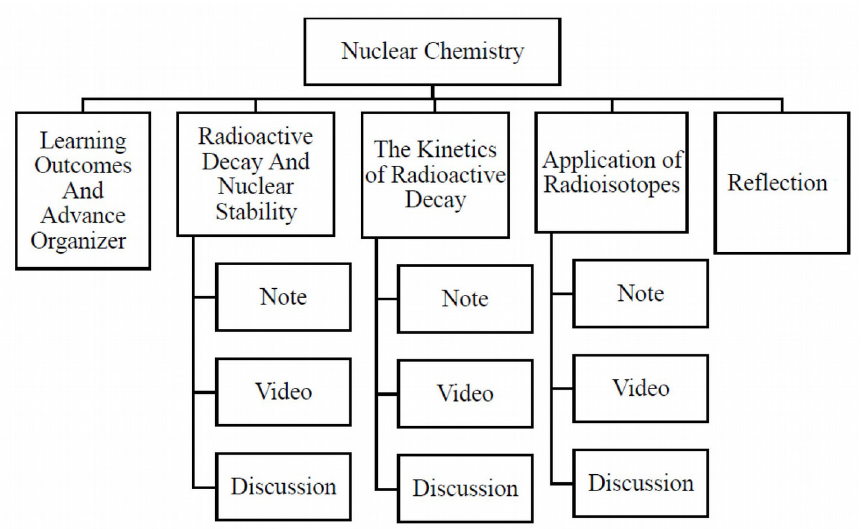
Figure 8. Storyboard used in designing the content of module (Hamid,